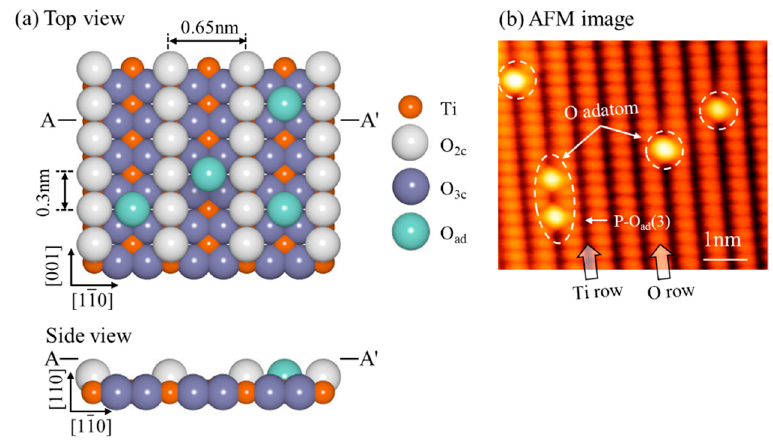
Figure 2. ( a ) Ball model of the rutile O-TiO 2 (110)-(1 × 1) surface. (Ti 5c : orange balls, O 3c : dark blue balls, O 2c : gray balls, O ad : light green balls) ( b ) AFM image of O-TiO 2 (110)-(1 × 1) surface. Bright and dark rows are O 2c and Ti 5c rows, respectively, and bright spot is O ad . ( f 0 = 807 kHz, Q = 23620, ∆ f = − 70 Hz, V DC = 0.6 V and A = 500 pm, image size: 6.3 × 5.3 nm 2 ).